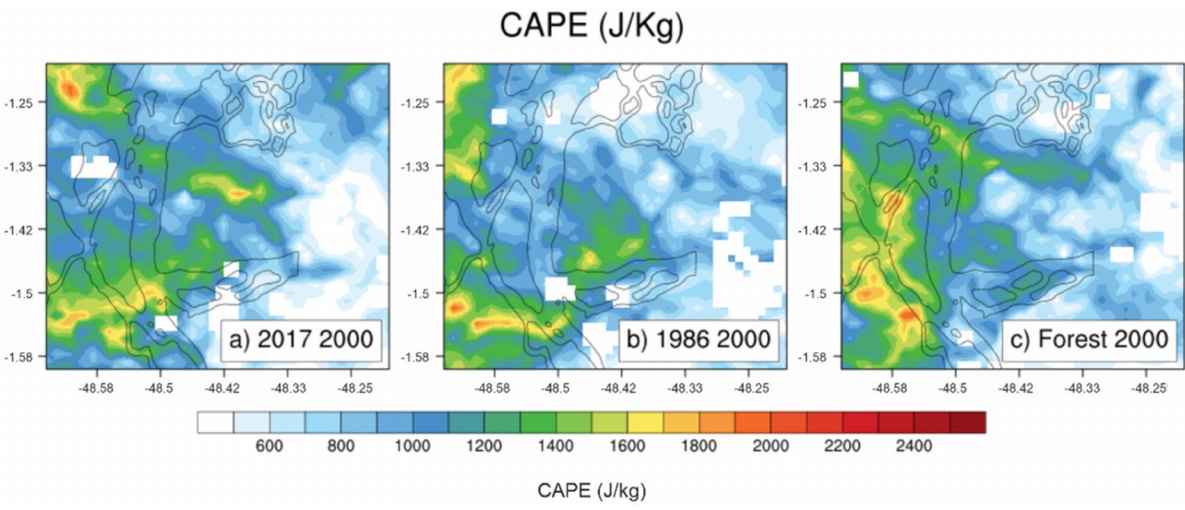
Figure 10. Convective available potential energy (CAPE) values simulated by the model for each scenario in